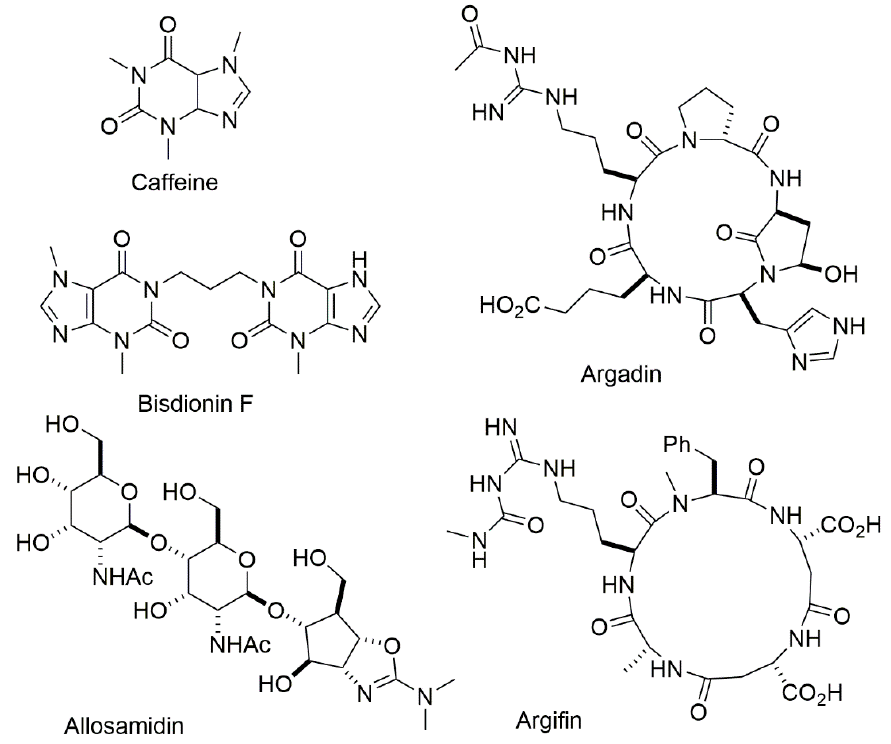
Figure 2. Examples of naturally occurring chitinase inhibitors.